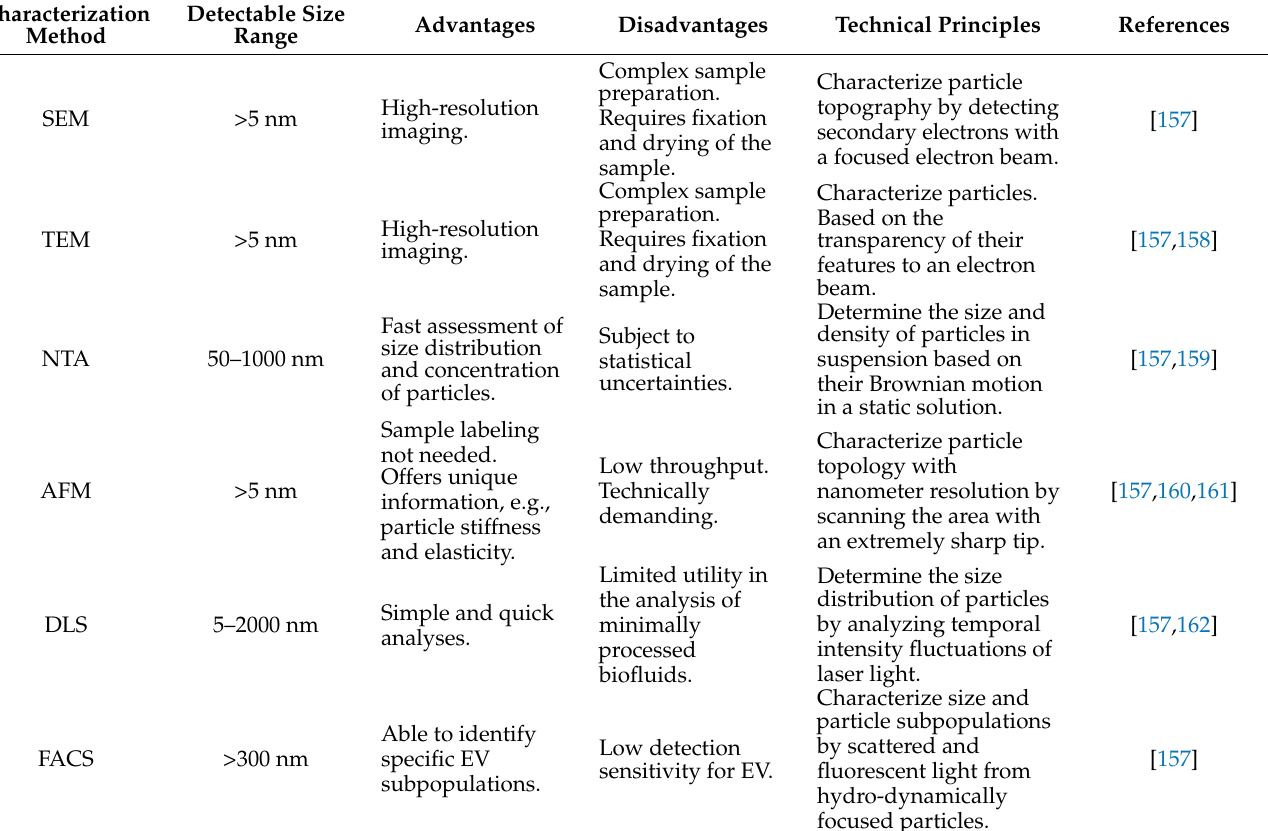
Table 4. Methods for characterization of